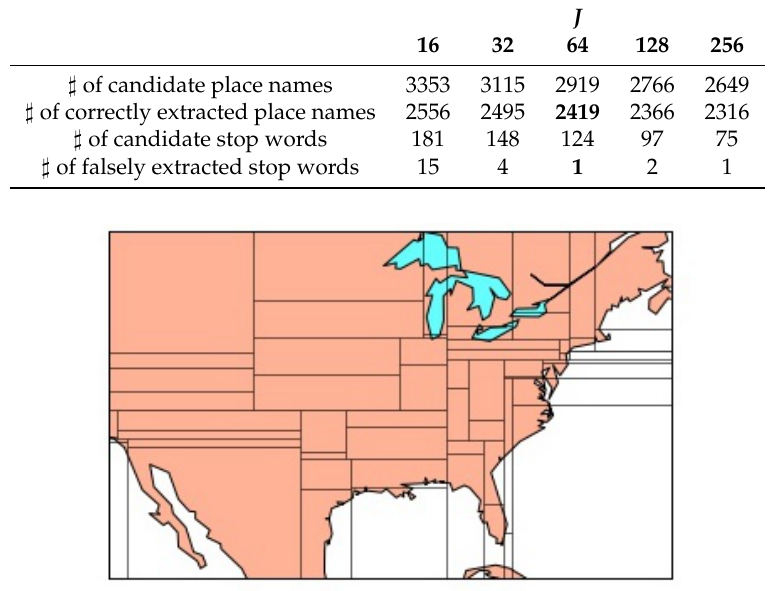
Table 2. Number of candidate local words and general words and correctly/falsely extracted place names and stop words when θ = 3.